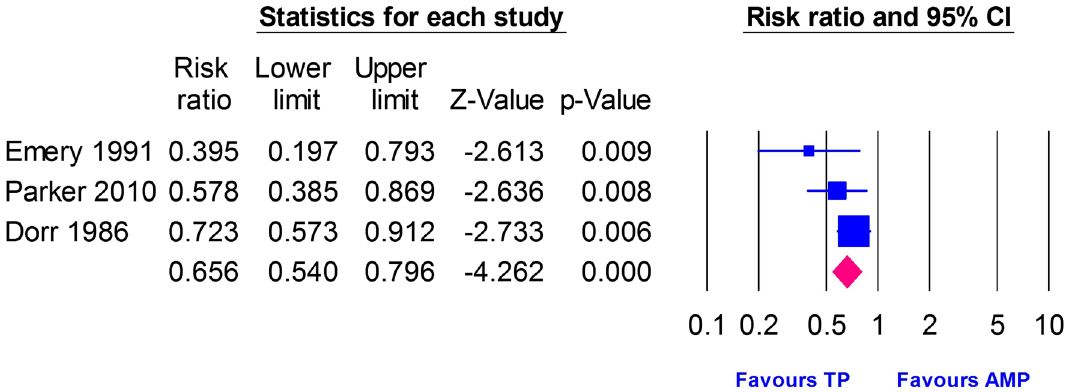
Figure 4. Forest plot of risk ratio (RR) of postoperative pain with 95% con fi dence interval, comparing Thompson and Austin Moore groups.